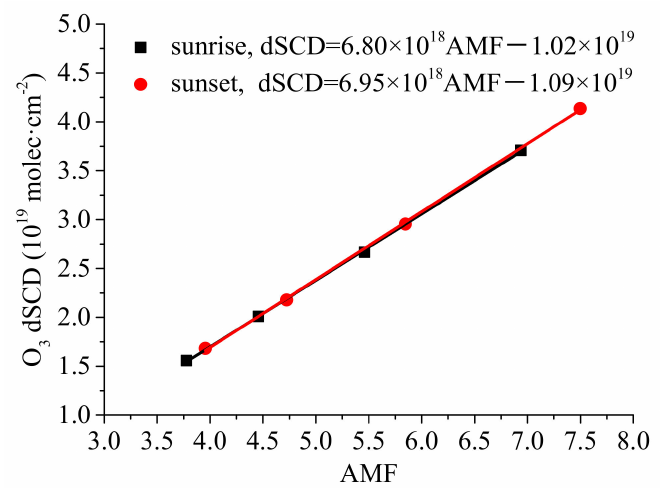
Figure 3. Example of the Langley plot method for O 3 in the SZA range of 75 ◦ –90 ◦ during sunrise and sunset on 30 August 2020. The black and red lines represent the linear fit between the O 3 dSCDs and AMFs for sunrise and sunset, respectively. The linear equations are also